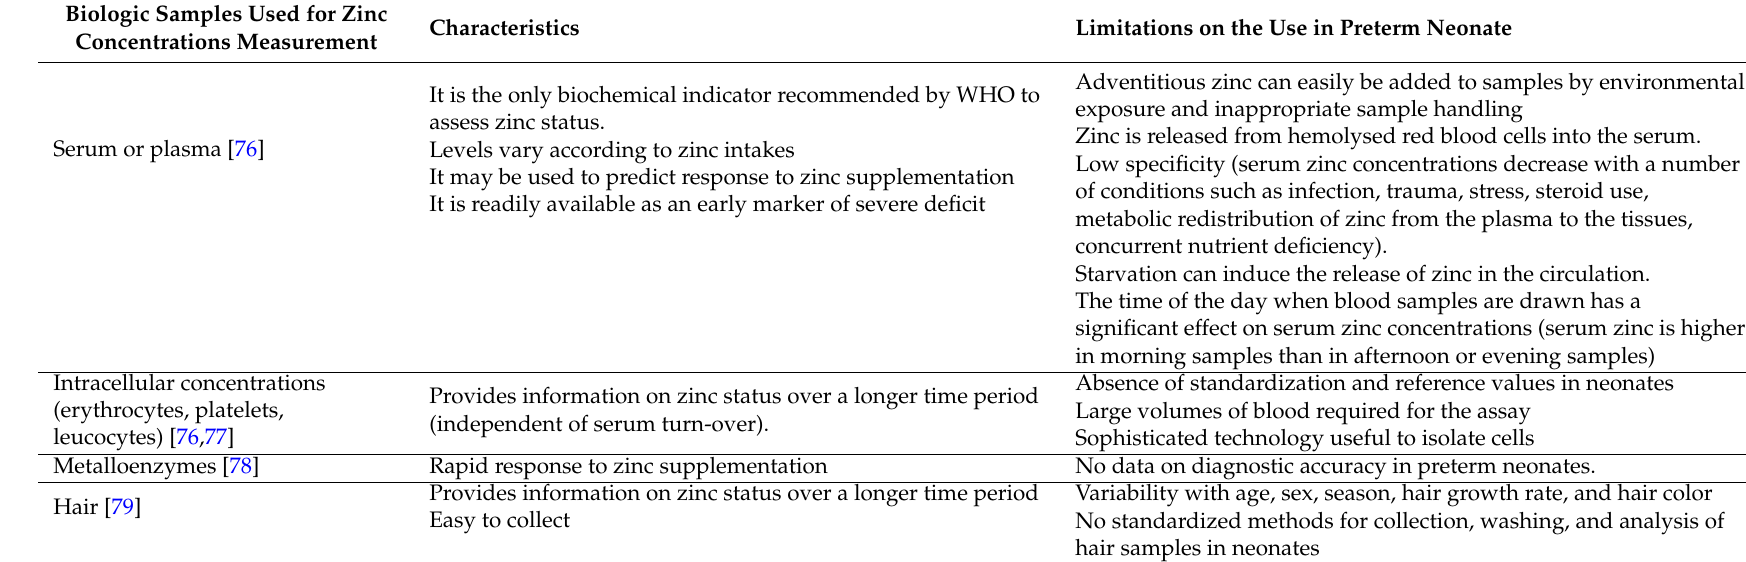
Table 5. Diagnostic tools for the diagnosis of zinc